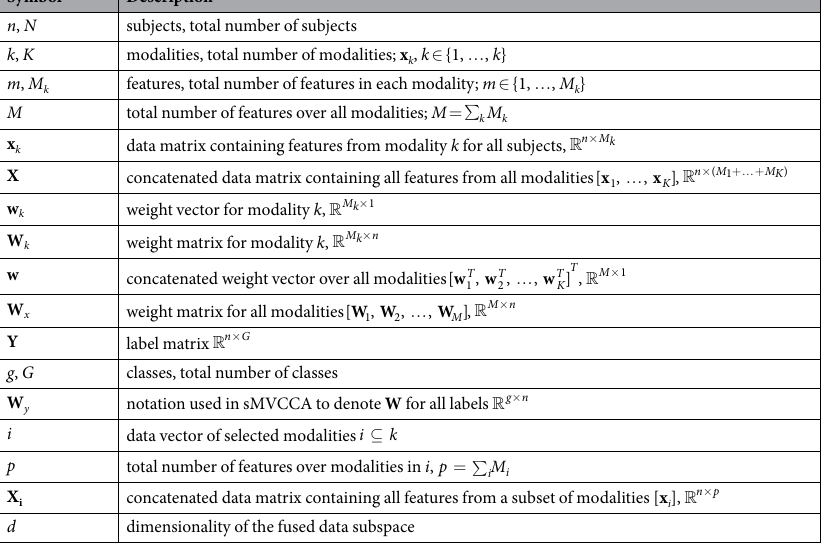
Table 2. Summary of